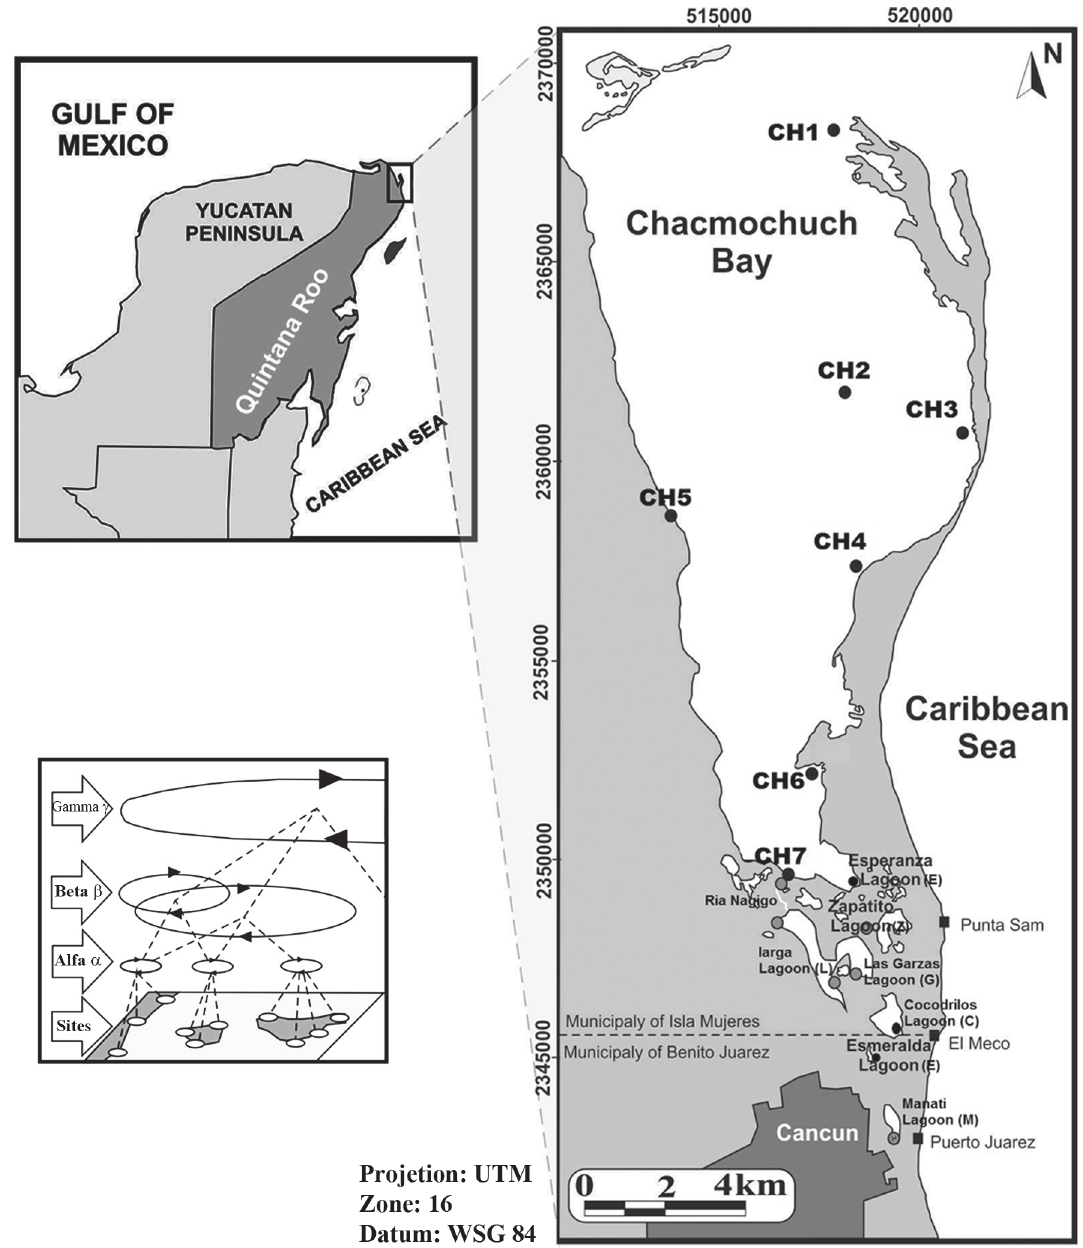
Fig. 1. Map showing the localization of Chacmochuch Lagoon System, and the biodiversity levels (alpha, beta and gamma) in the system. The location of sites is indicated in the